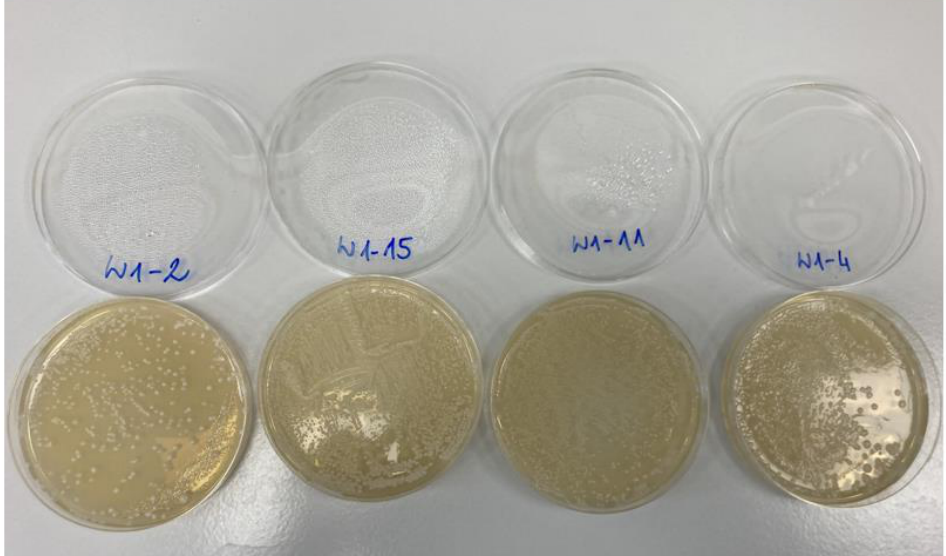
Figure 1. An example view of microbial cultivation in non-alcoholic beer. The labels correspond to the following batches: W1-2 is B0; W1-15 is ME40; W1-11 is AC40, W1-4 is AE60. the following batches: W1-2 is B0; W1-15 is ME40; W1-11 is AC40, W1-4 is